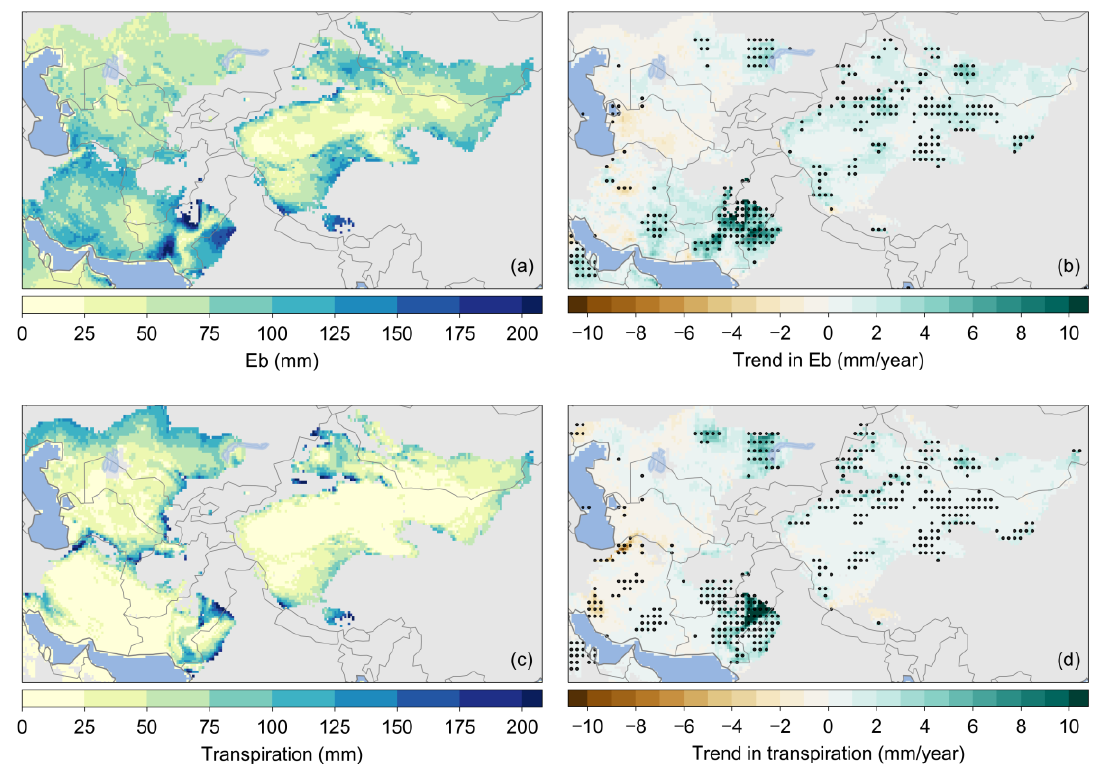
Figure 2. Multi-year mean annual evaporation from bare soil (Eb) and transpiration (Ts), and the trend in annual Eb and Ts from 2003 to